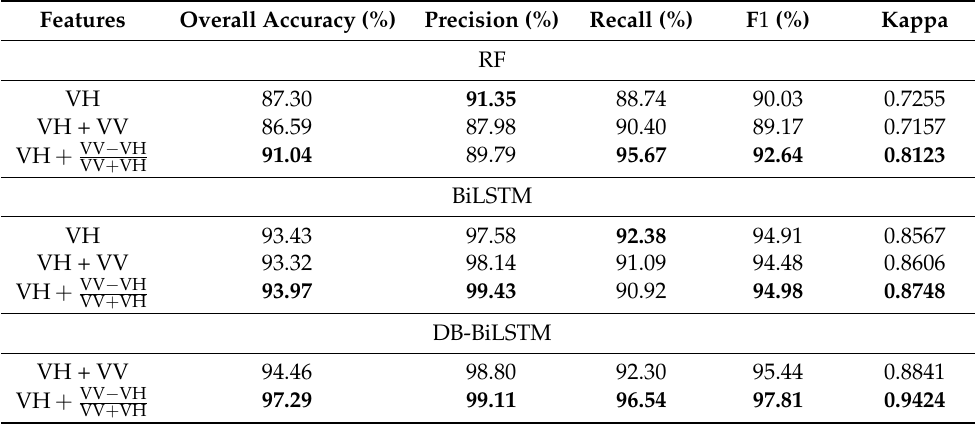
Table 4. Accuracy assessment of different